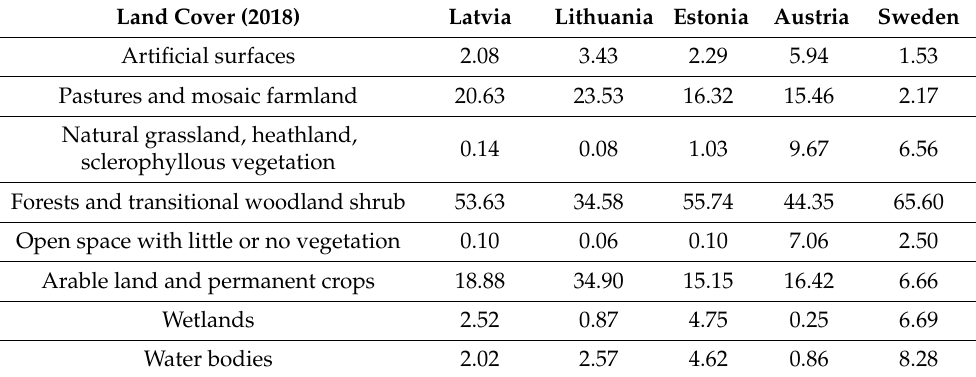
Table 3. Land cover (land-use categories) according to EEA data (2018) shares (%) in selected European countries